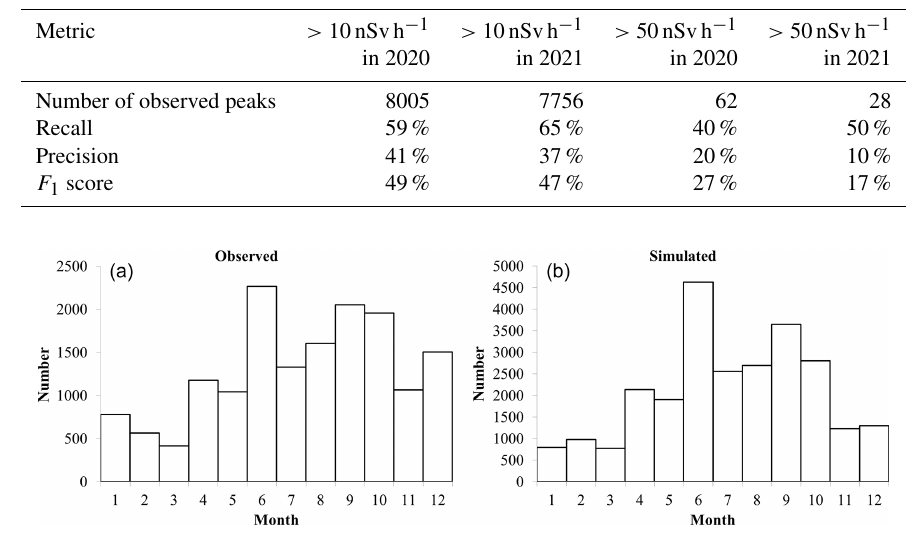
Figure 13. Monthly distribution of the peaks for the period 2020–2021. (a) Observed peaks. (b) Simulated peaks.